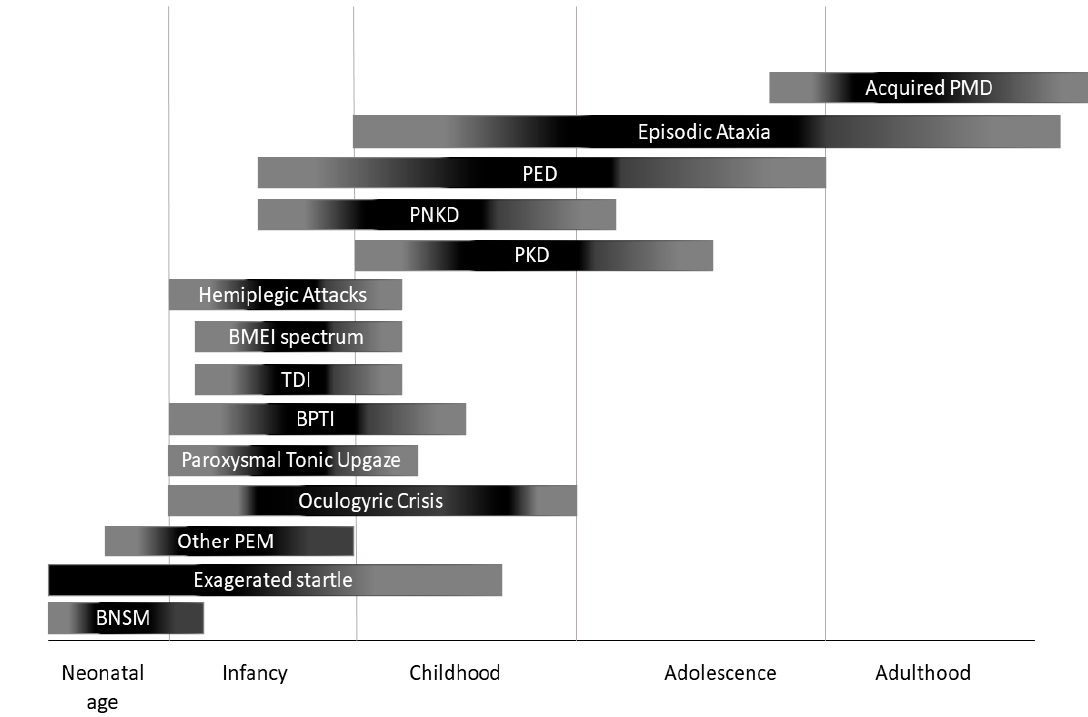
Figure 1. Onset of different paroxysmal movement disorders (PMDs) according with age. BNSM: benign neonatal sleep myoclonus; BMEI: benign myoclonus of early infancy; BPTI: Benign paroxysmal torticollis of infancy; PEM: Paroxysmal eye movements; PED: Paroxysmal exercise-induced dyskinesia; PKD: Paroxysmal kynesigenic dyskinesia; PNKD: Paroxysmal non-kynesigenic dyskinesia. Table 1. Main genetic causes of paroxysmal movement disorders. A question mark follows treatment options that: have been proposed basing on pathophysiological assumptions, are under investigation or have been shown to be beneficial only in single-case reports.